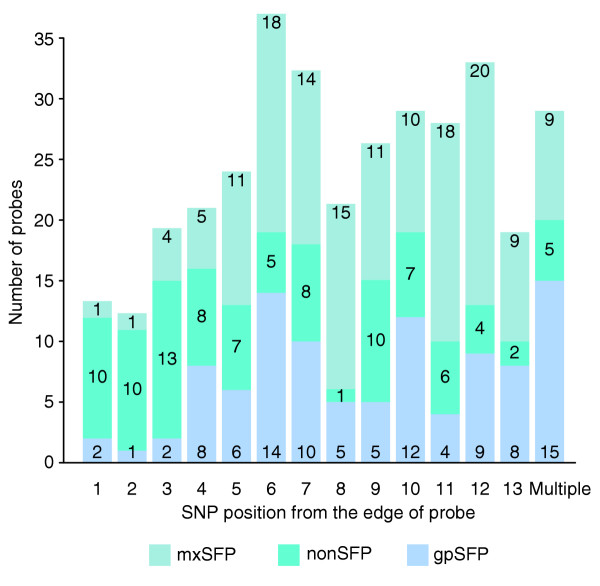
Effect of SNP position on SFP identification. The positions of the SNP in 25mers are shown on the x-axis as distance from the edge in nucleotides (1 - 13 nucleotides). Multiple SNP category is provided separately by a single column. The y-axis indicates total number of probes identified for each SNP position. Each bar is divided into the SFP categories - mxSFP, nonSFP and gpSFP (see Table 2), and shows that more accurate SFP identification is made for SNPs that reside at internal sites. The number of 25mers in each category is shown within the bars.